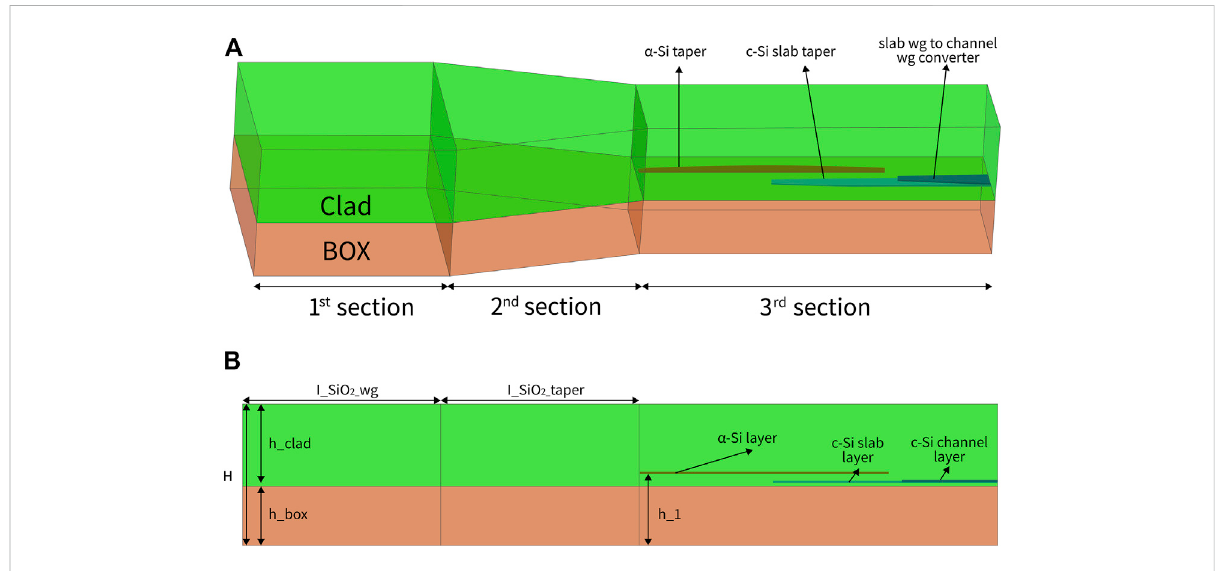
FIGURE 1 (A) Core structures and (B) side view of the double-layered edge